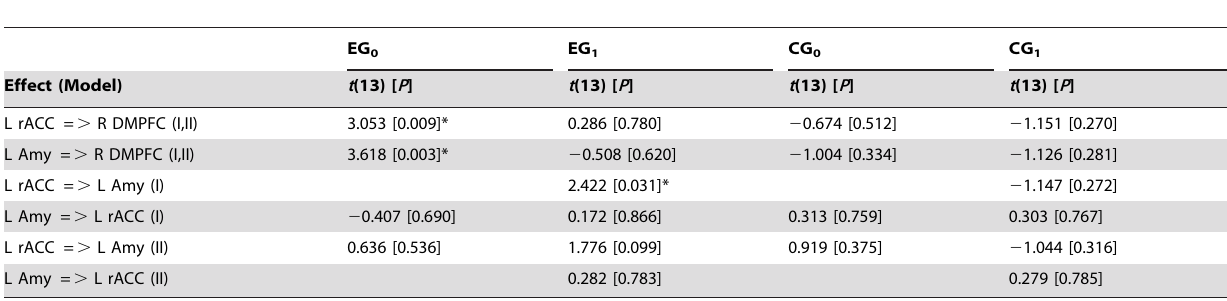
The table contains linear trend t -statistics for the SVAR path coefficients across the neurofeedback runs (RE…R3) with the corresponding group P -values. Each data row corresponds to a subplot in Fig. 7. An empty cell means an absence of the corresponding interaction from a model. Notations are the same as in Fig. 7. *indicate significant effect.